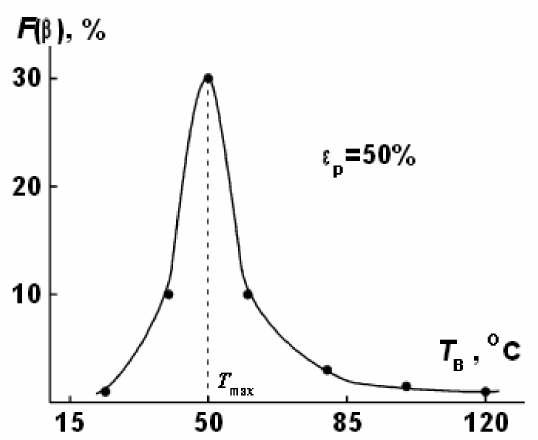
Figure 6. Dependence of the fraction of crystallites of the β -phase on the stretching temperature at a stretching ratio of 50% [77].